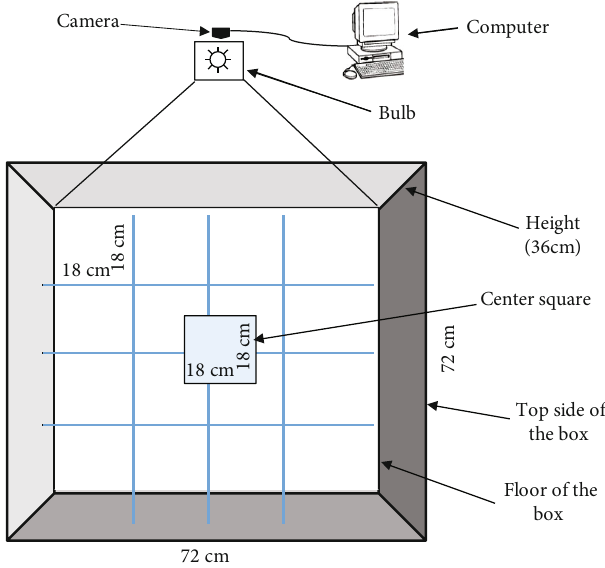
Figure 1: The open- fi eld